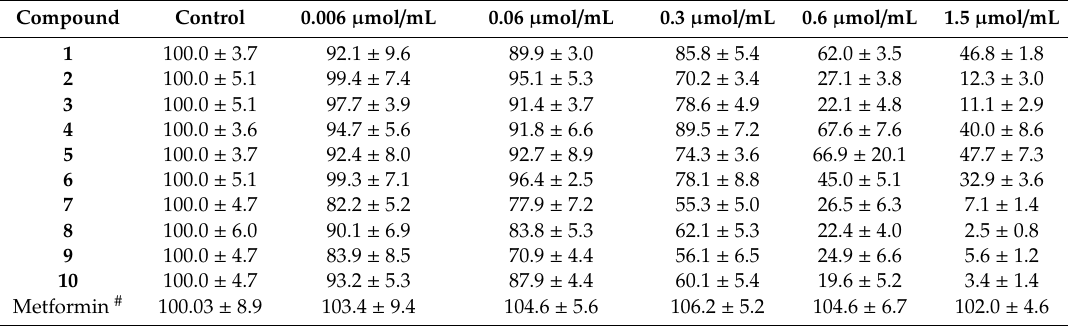
Table 3. The e ff ects of sulfonamides on HUVEC cells growth. The results (viability, %) are presented as mean ± SD ( n =